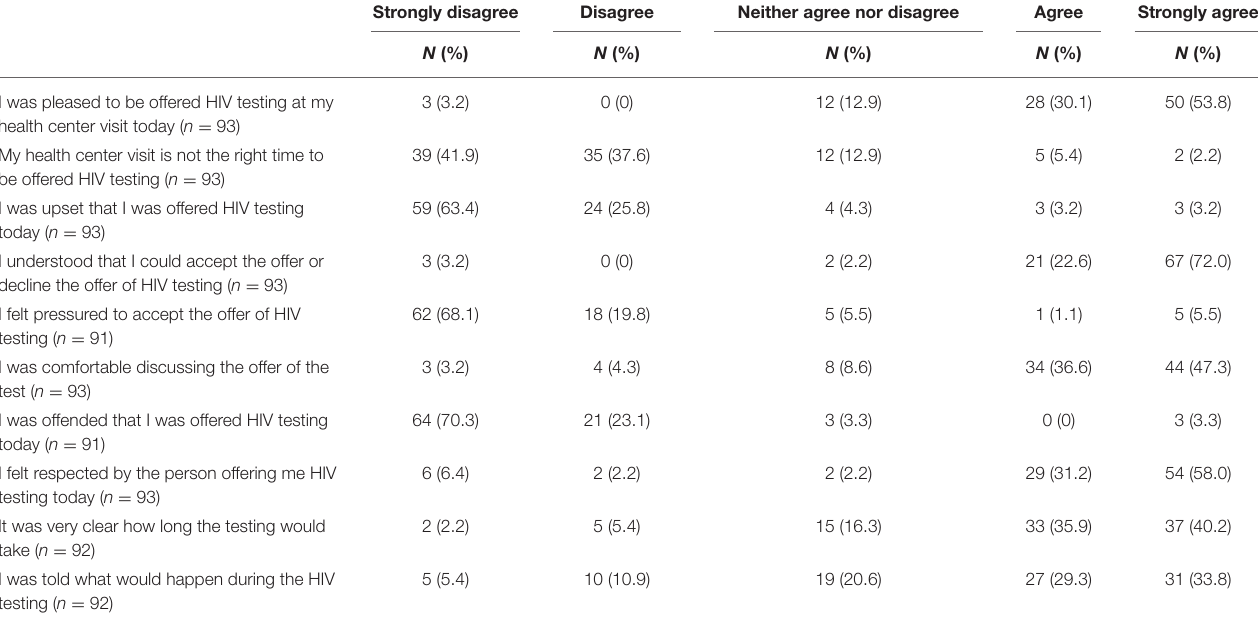
TABLE 2 | Patients’ Perspectives on Being Offered an HIV POC Test at their Health Services Appointment. Strongly disagree